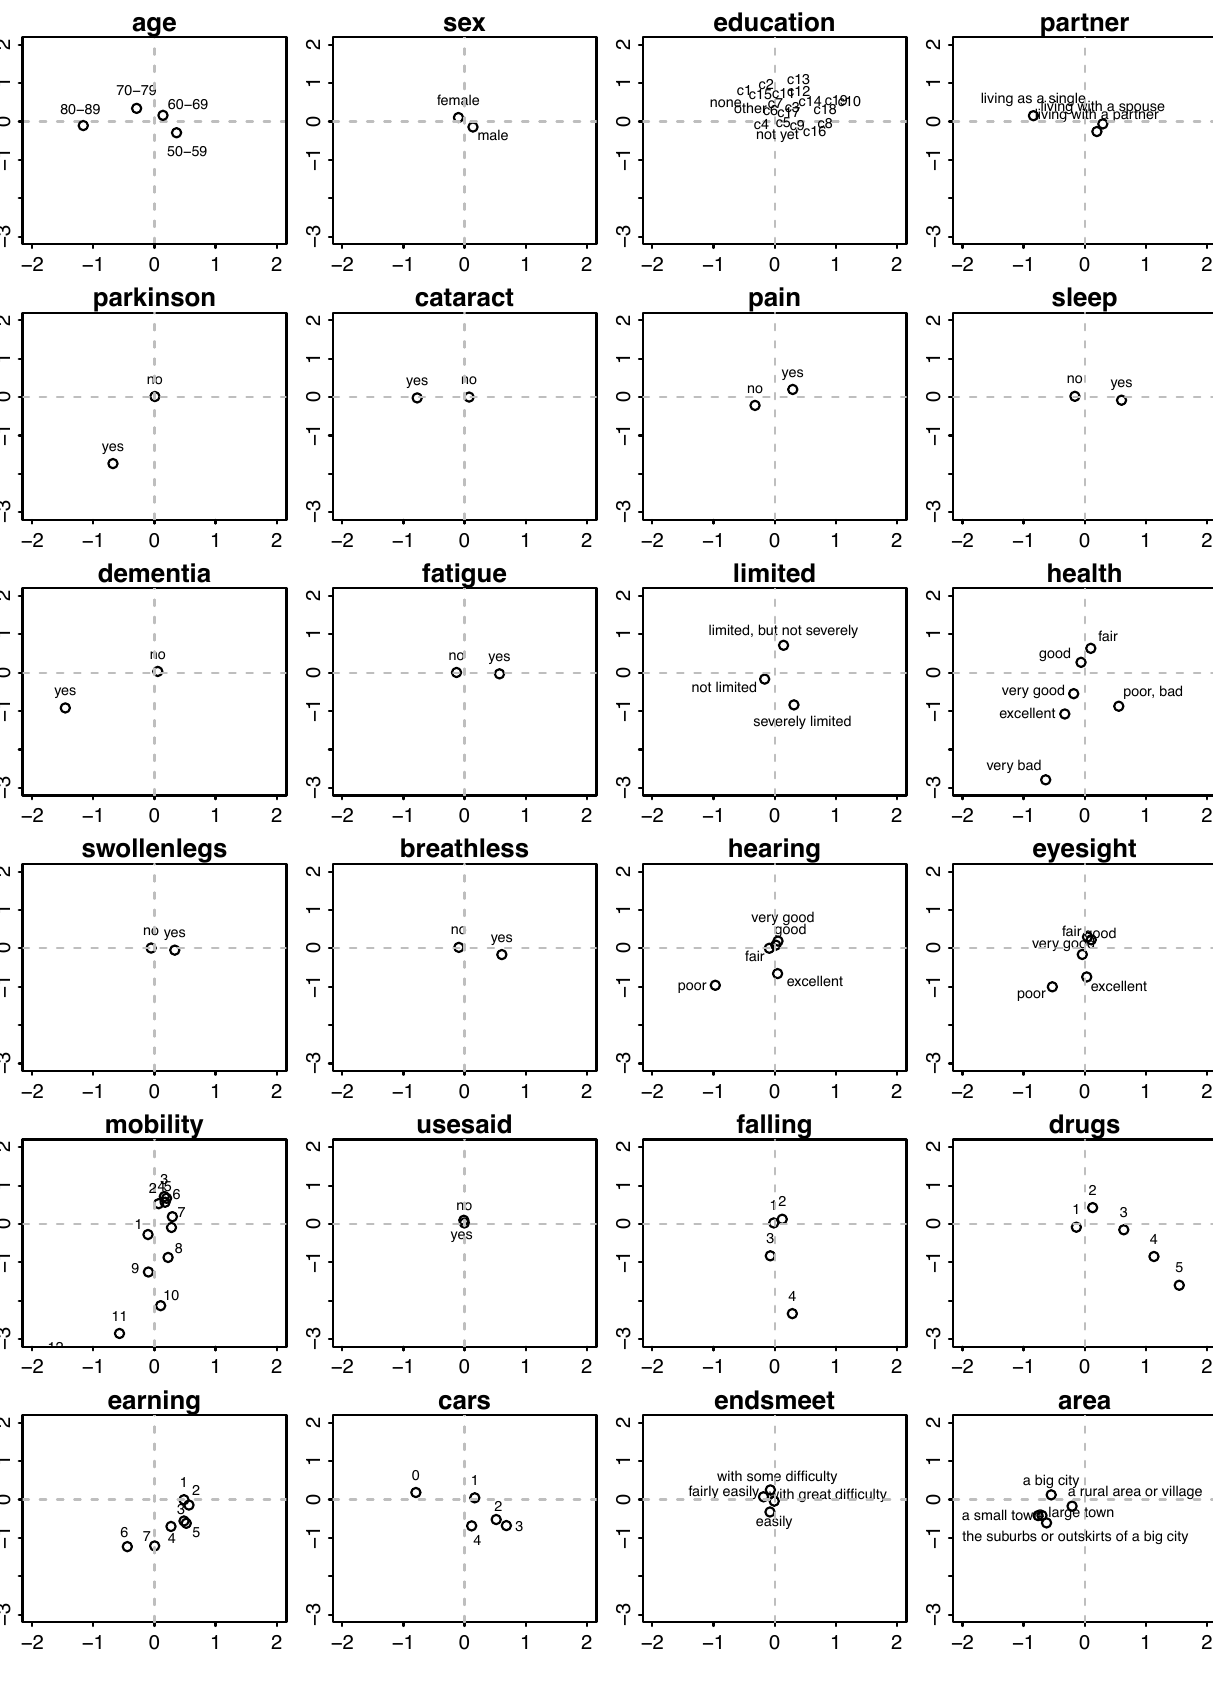
Figure 5. Category quantifications on Component 3 (horizontal) and Component 2 (vertical) per variable (Front